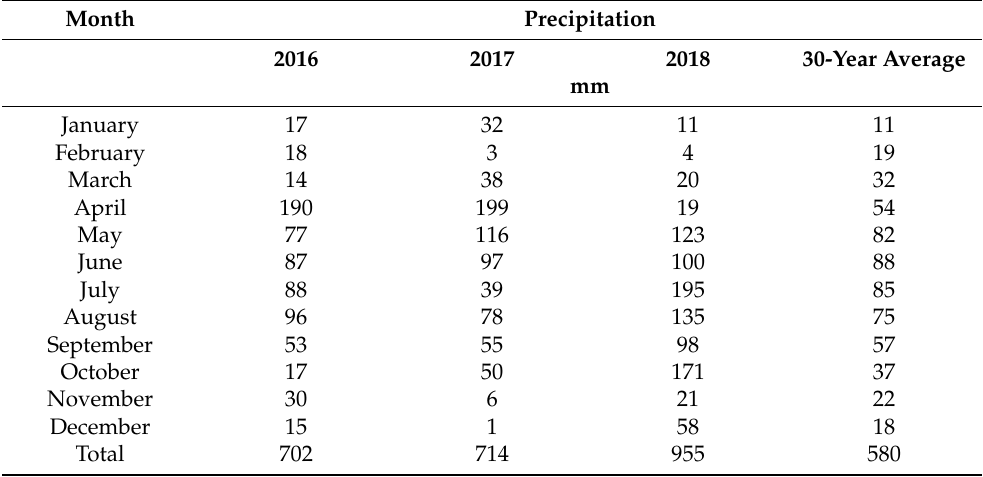
Table 1. Monthly precipitation amounts at Hays, KS from 2016 to